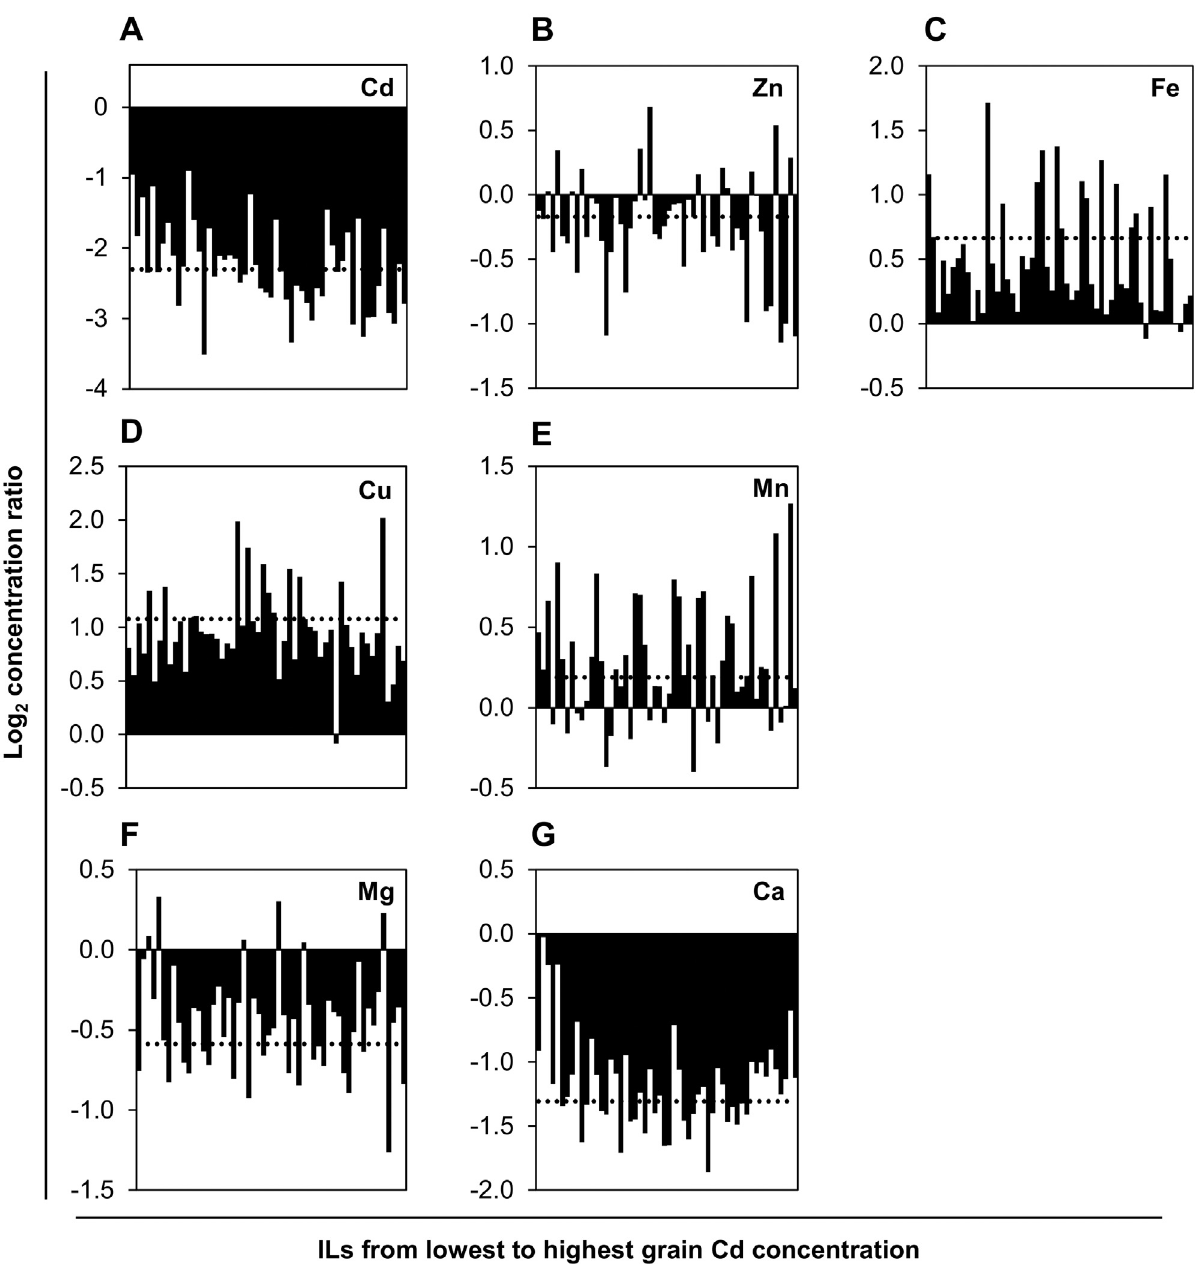
Fig 3. Element accumulation in young leaf relative to flag leaf of 54 barley introgression lines. Shown are Log 2 ratios of element concentrations in the young leaf versus the flag leaf for (A) Cd, (B) Zn, (C) Fe, (D) Cu, (E) Mn, (F) Mg, and (G) Ca. Each bar represents the least-square mean of one IL ( n = 3 to 7), with ILs sorted by ascending grain Cd concentration from left to right. Dashed horizontal lines indicate the position of the least-square mean of the recurrent parent Scarlett ( n = 144). Measurements were from the same experiment as shown in Fig 1.